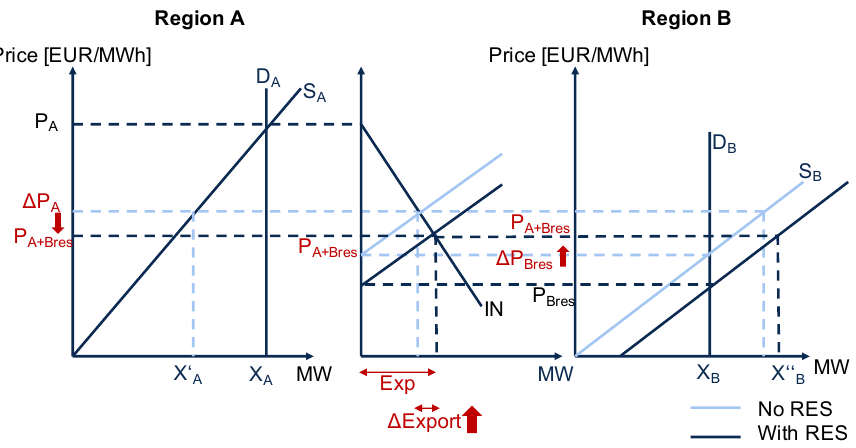
Figure 3. Graphical representation of cross-border exchange with VRE, source: own